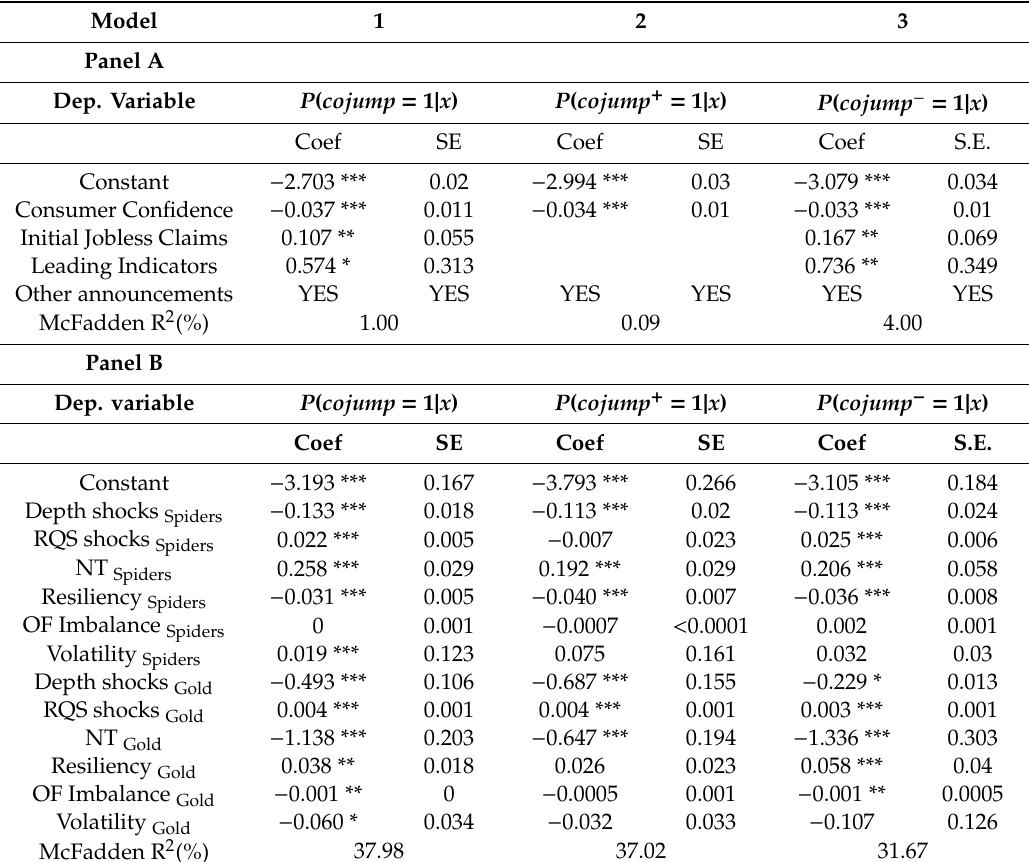
Table 5. Cojumps, liquidity, and macroeconomic